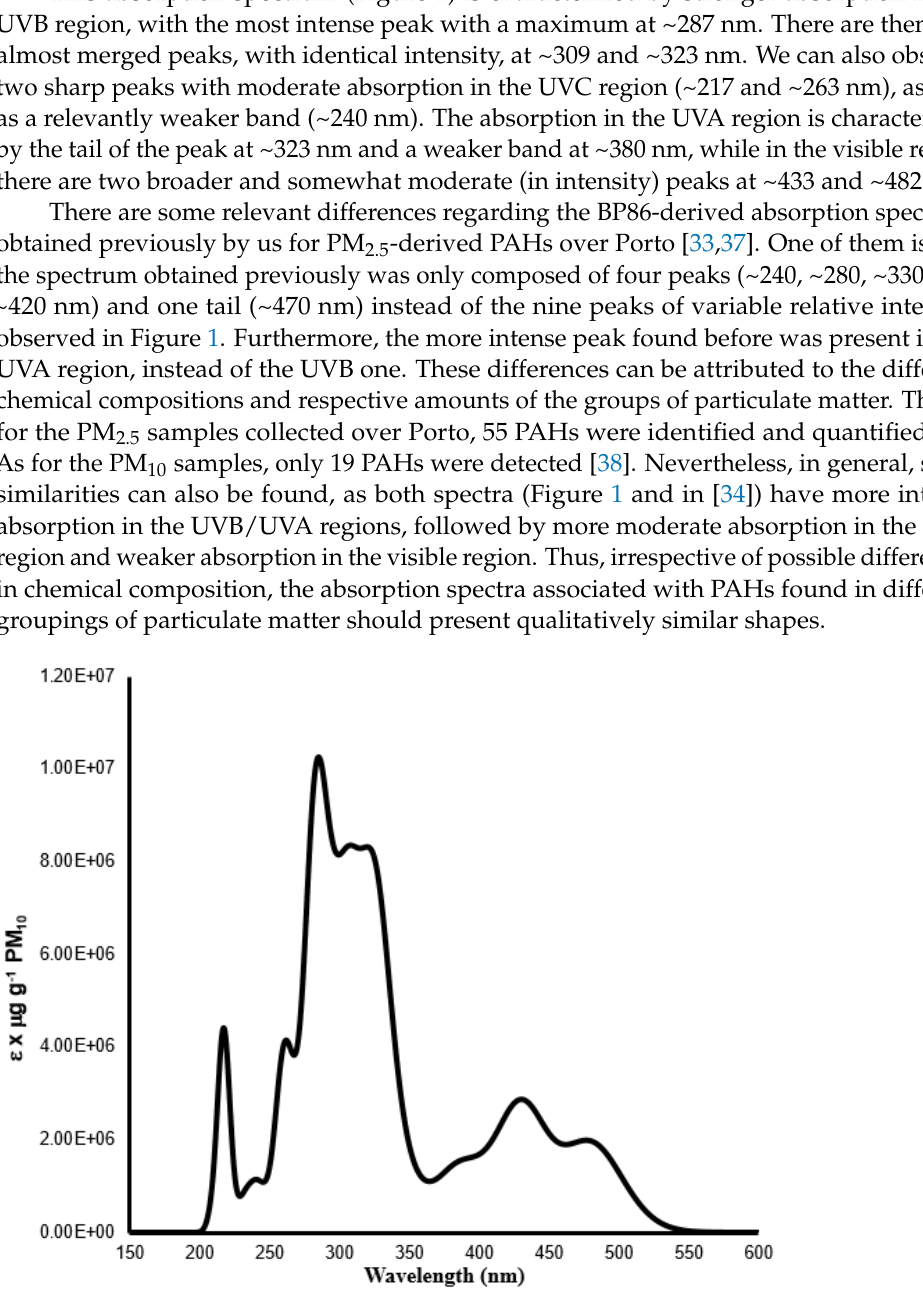
Figure 1. Combined theoretical absorption spectra of PAHs, when corrected for their experimental mean amount ( μ g g -1 PM 10 ) [38] over Porto, by using TD-BP86/6-31+G(d,p).